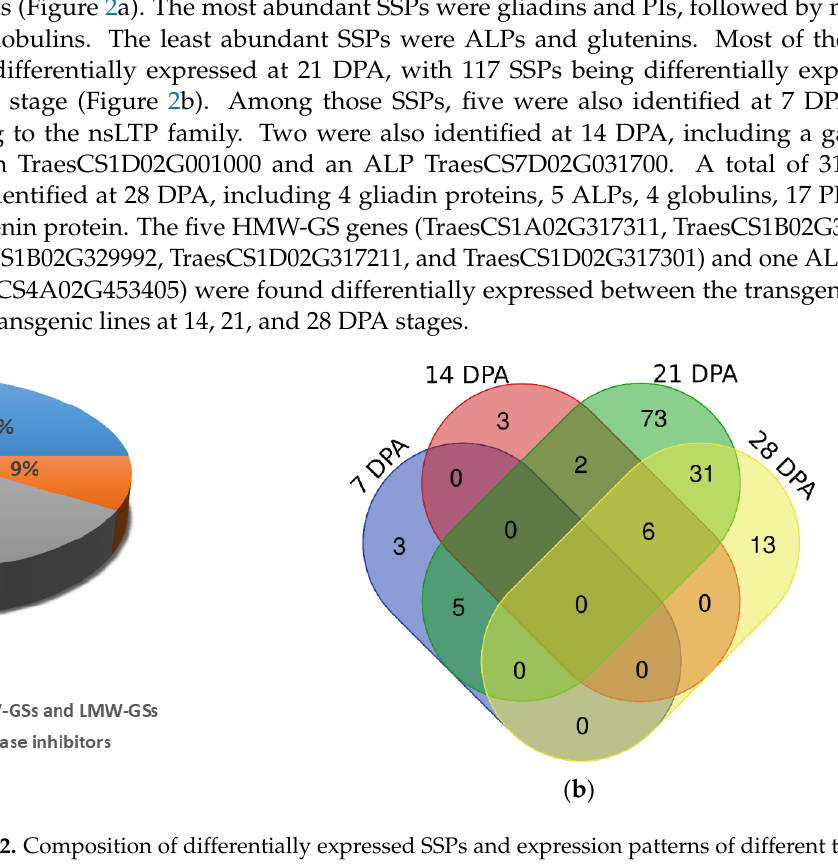
Table 3. Expression trends of different types of SSPs at different stages. 7 DPA